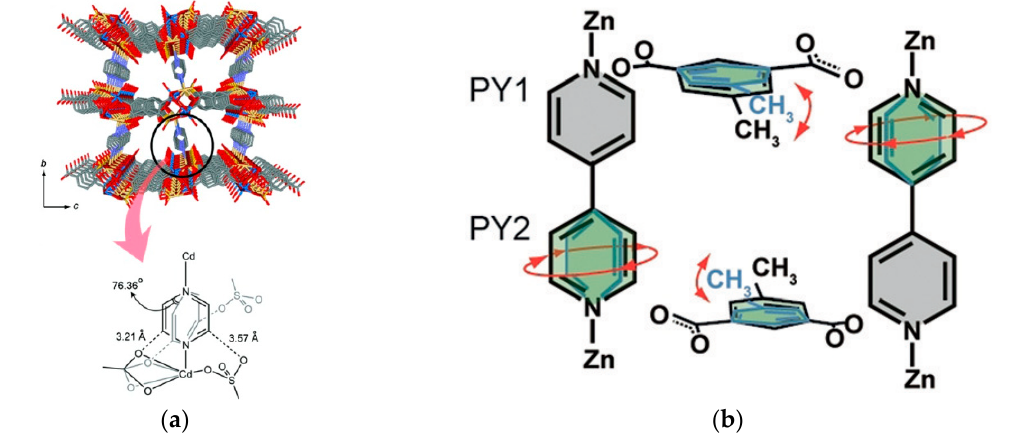
Figure 4. Structure of two N-linker rotor-based MOFs. ( a ) CdNa(2-stp)(pyz) 0.5 (H 2 O), with an illustration of the two disorder positions of the linker; ( b ) 2D stacked framework, Zn(5-Me-isophthalate) (bipyridine). Reproduced with permission from [26] and [31]. Copyright Wiley-VCH, 2006. Copyright Wiley-VCH,